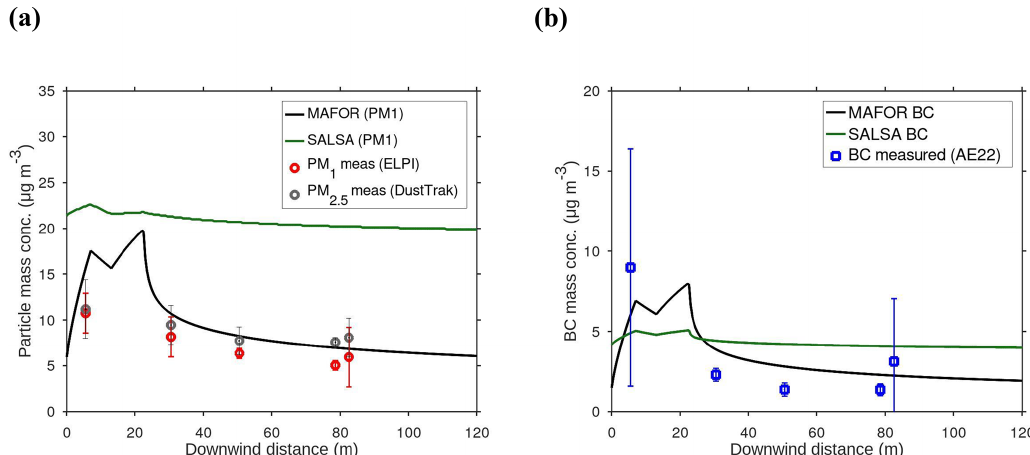
Figure 12. Comparison of total particle mass and black carbon concentrations in the Urban Case simulation: (a) modelled particulate matter (PM 1 ) from MAFOR and SALSA together with measured PM 1 from ELPI (assuming particle density of 1000kgm − 3 ) and PM 2 . 5 from DustTrak (error bars represent 1 σ standard deviation); (b) modelled BC from MAFOR and SALSA together with measured BC with an Aethalometer (AE22, Magee Scientific; error bars represent 1 σ standard deviation). Measurement data were obtained with the mobile lab Sniffer at location points A–E. Note that point E was excluded from the M–O